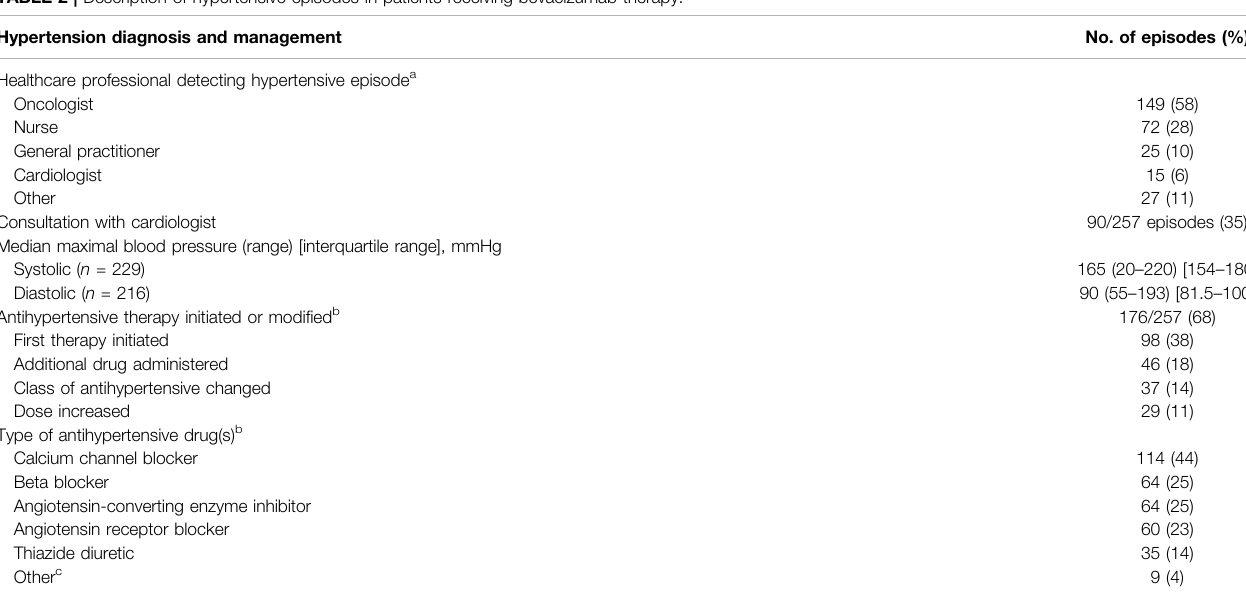
TABLE 2 | Description of hypertensive episodes in patients receiving bevacizumab